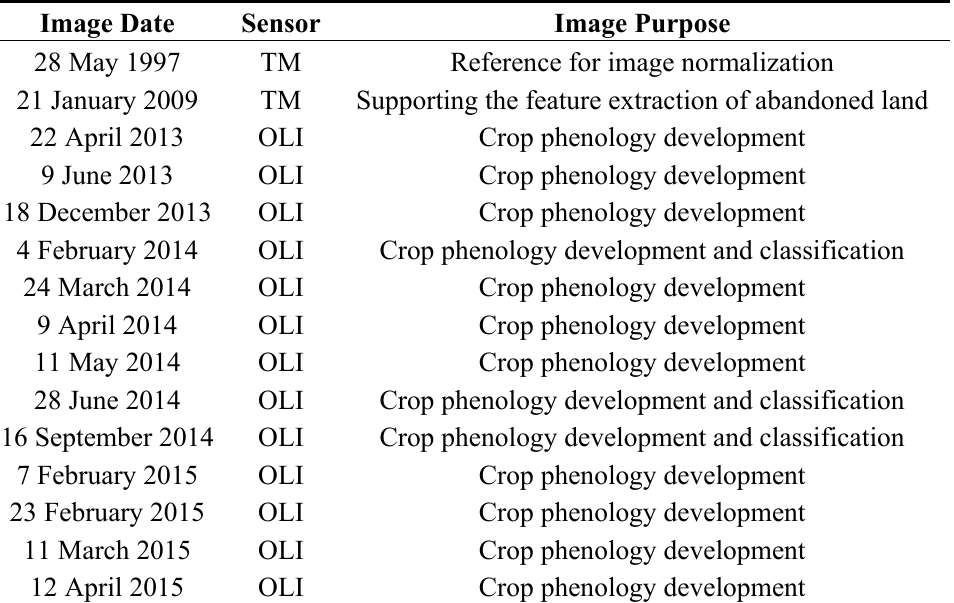
Table 1. Landsat images